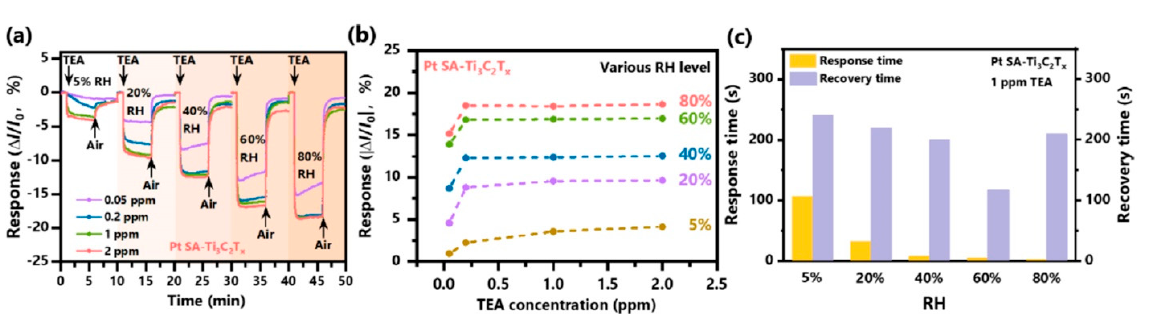
Figure 39. ( a ) Sensor responses to triethylamine (TEA) (0.05–2 ppm) under various RH (5 to 80%). ( b ) Plots of sensor response vs. TEA concentration from ( a ). ( c ) Response and recovery times of the Ti 3 C 2 T x /Pt sensor toward 1 ppm TEA at various RHs. Reprinted with permission from [177]. Copyright 2022: American Chemical Society.